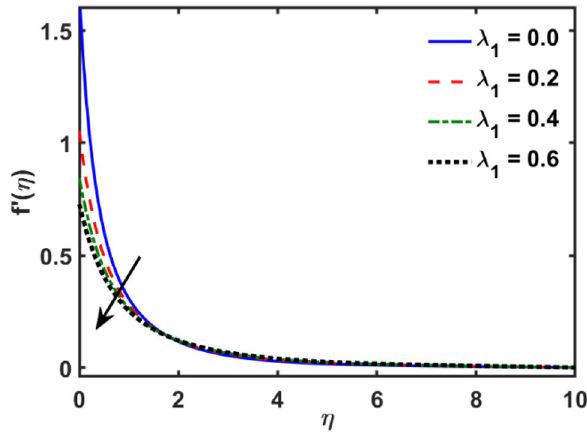
Figure 4. Variation of (cid:31) 1 on f ′ (η) .